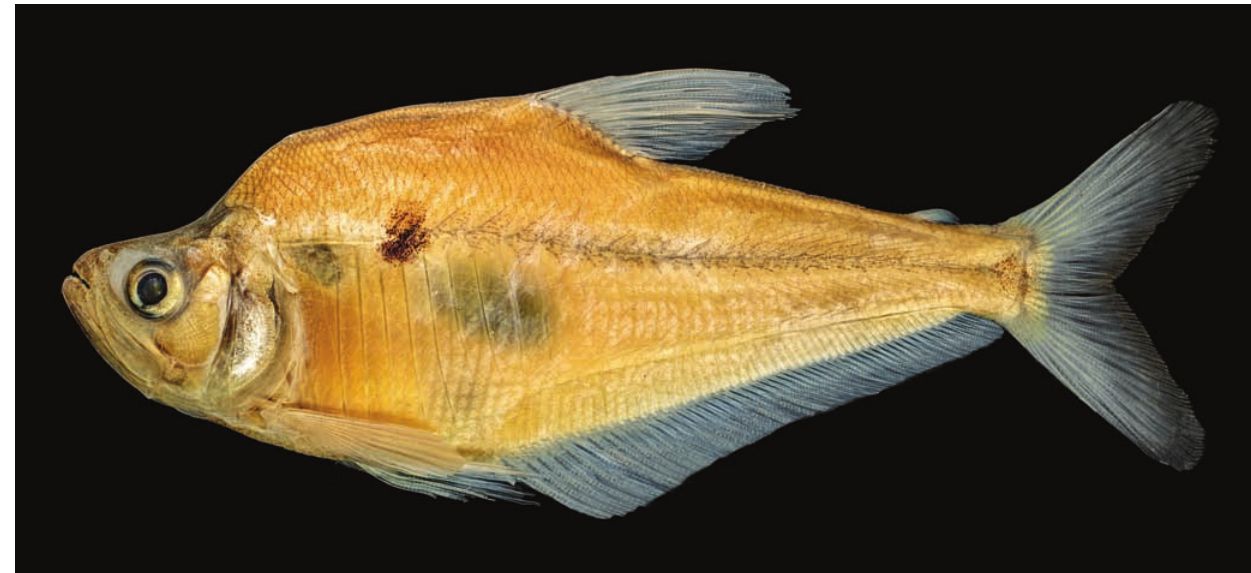
Fig. 11. Charax gibbosus MZUSP 10674, female, 124.5 mm SL, Suriname, Sara Creek, Brokopondo